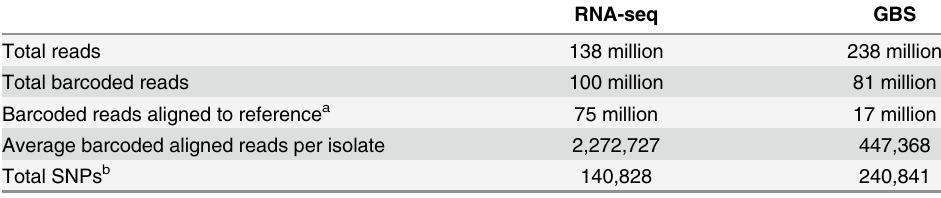
Table 2. Sequencing and alignment results from RNA-seq (n = 33) or GBS (n = 38) analysis. RNA-seq GBS Total reads 138 million 238 million Total barcoded reads 100 million 81 million Barcoded reads aligned to reference a 75 million 17 million Average barcoded aligned reads per isolate Total SNPs b 140,828